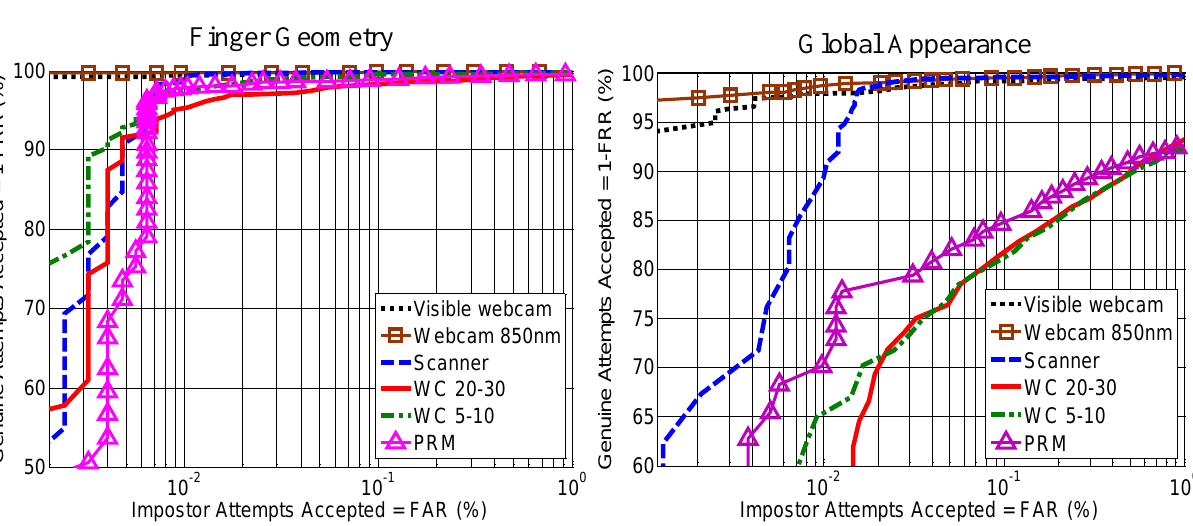
Figure 17. ROC curves for hand shape features extraction methods, geometric (left) and global appearance (right).